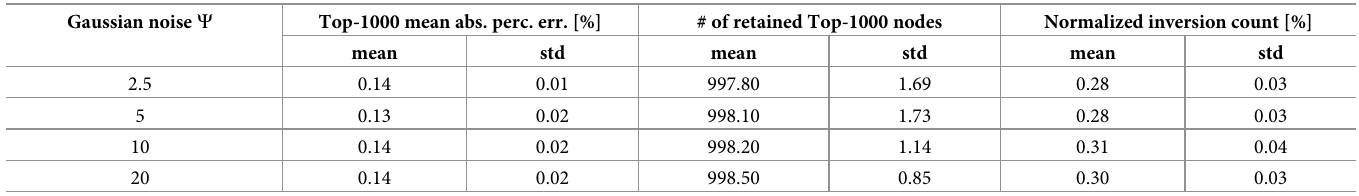
Table 3. Accuracy of W2C-Fast-BC with respect to Brandes on the noisy graph. Mean and standard deviation are reported for each accuracy indicator as obtained by aggregating over the 10 instances of the noisy graph ^ G for each value of C 08:00